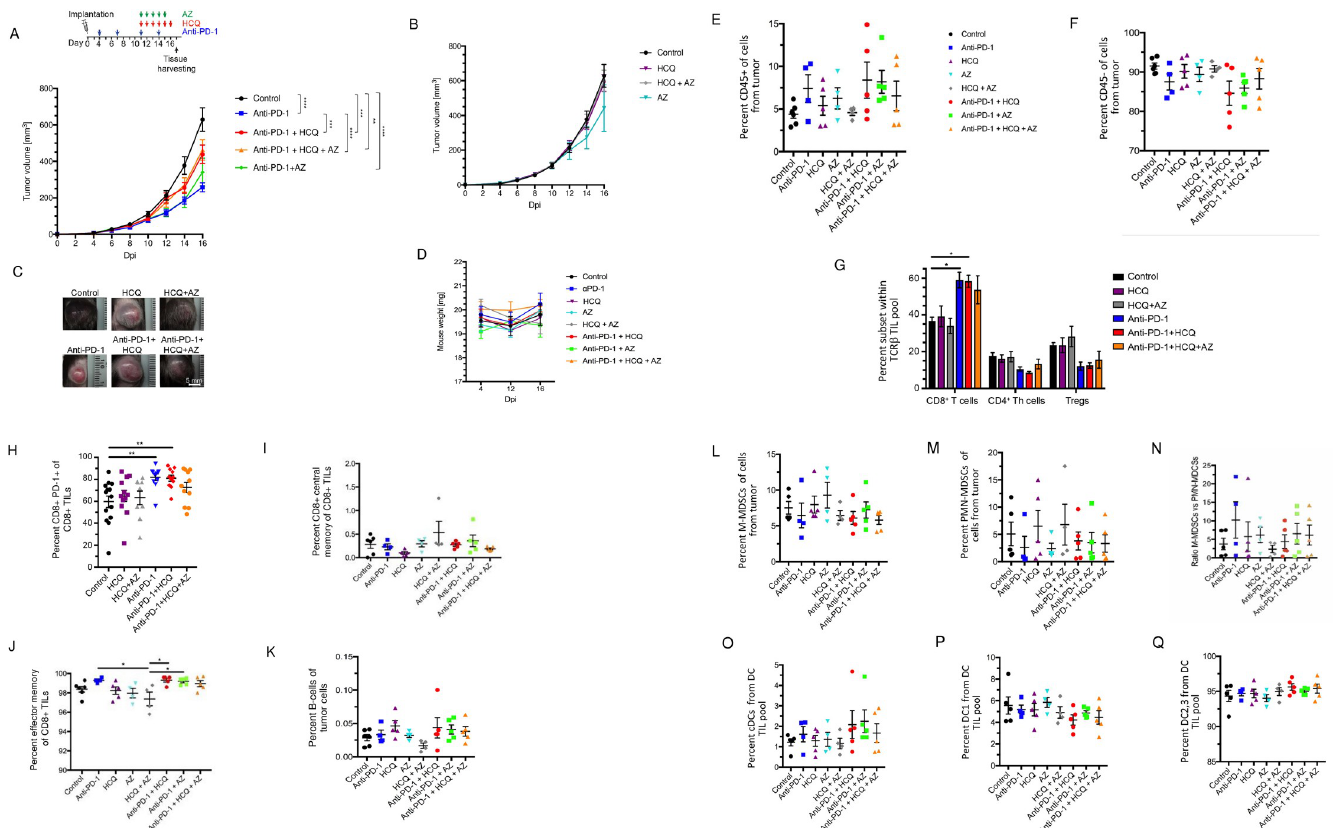
Fig 1. Hydroxychloroquine and azithromycin reverse partially immune checkpoint blockade in cancer therapy. C57BL/6 mice were implanted intradermally with B16-PD-L1 tumor cells. Following 1 week of anti-PD-1 treatment, HCQ with or without AZ were injected daily before tumors were harvested at day 17 post implantation. Panel A: Tumor volumes in response to anti-PD-1 plus HCQ and AZ. Panel B: Tumor volumes in mice treated only with HCQ and AZ. Panel C: Examples of tumors from mice treated with HCQ, AZ or anti-PD-1 plus HCQ and AZ. Panel D: Percentage of mouse weight loss over time. Panel E: Percentage of total immune cell infiltrate (CD45 + cells). Panel F: Percentage of CD45 - cells in tumors. Panel G: Percentage of CD8 + , CD4 + T helper and regulatory T cells (Tregs) of total TCRb + cells in tumor. Panel H: Percentage of PD-1 + CD8 + TILs. Panel I: The effect of therapy on CD8 + central memory TILs. Panel J: The effect of therapy on CD8 + effector memory TILs. Panel K: The effect of therapy on B cell TILs. Panel L: The effect of therapy on the percentage representation of M-MDSC TILs. Panel M: The effect of therapy on the percentage representation of PMN-MDSC TILs. Panel N: Ratio of M-MDSC TILs relative to PMN-MDSC TILs. Panel O: The effect of therapy on the percentage representation of cDC TILs. Panel P: The effect of therapy on the percentage representation of DC1 TILsc. Panel Q: The effect of therapy on the percentage representation of DC2 and 3 TILs.